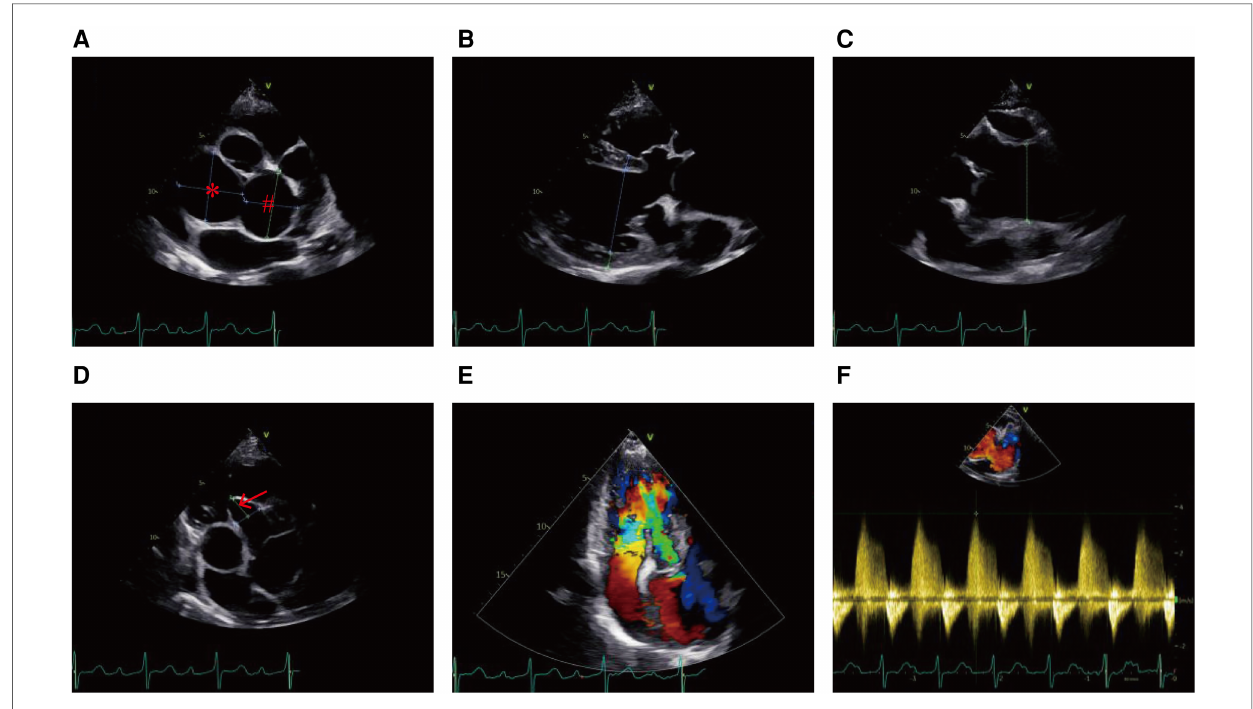
FIGURE 2 Echocardiogram showing ( A ) the unruptured left SVA (#) and non-coronary SVA (*), ( B ) enlarged left ventricle, ( C ) dilated aortic root, ( D ) ventricular septal membranous aneurysm (red arrow), ( E ) severe aortic regurgitation, and ( F ) right ventricular high